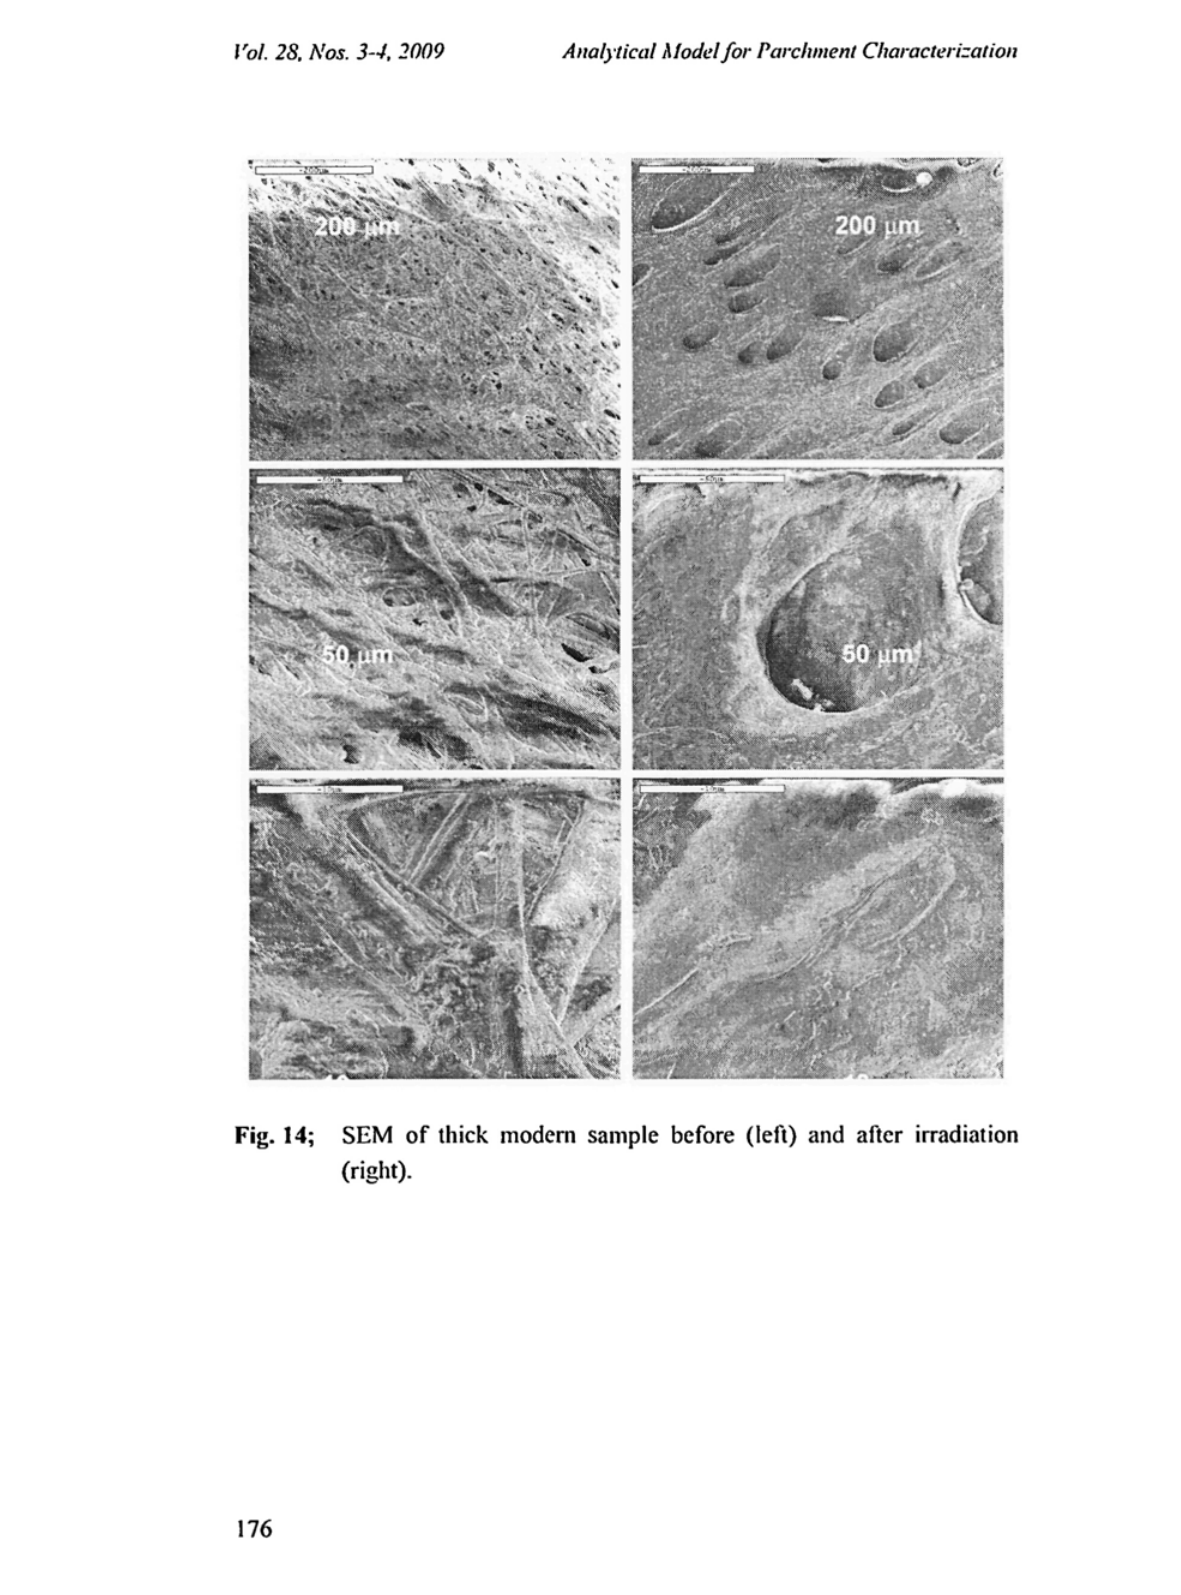
Fig. 14; SEM of thick modern sample before (left) and after irradiation